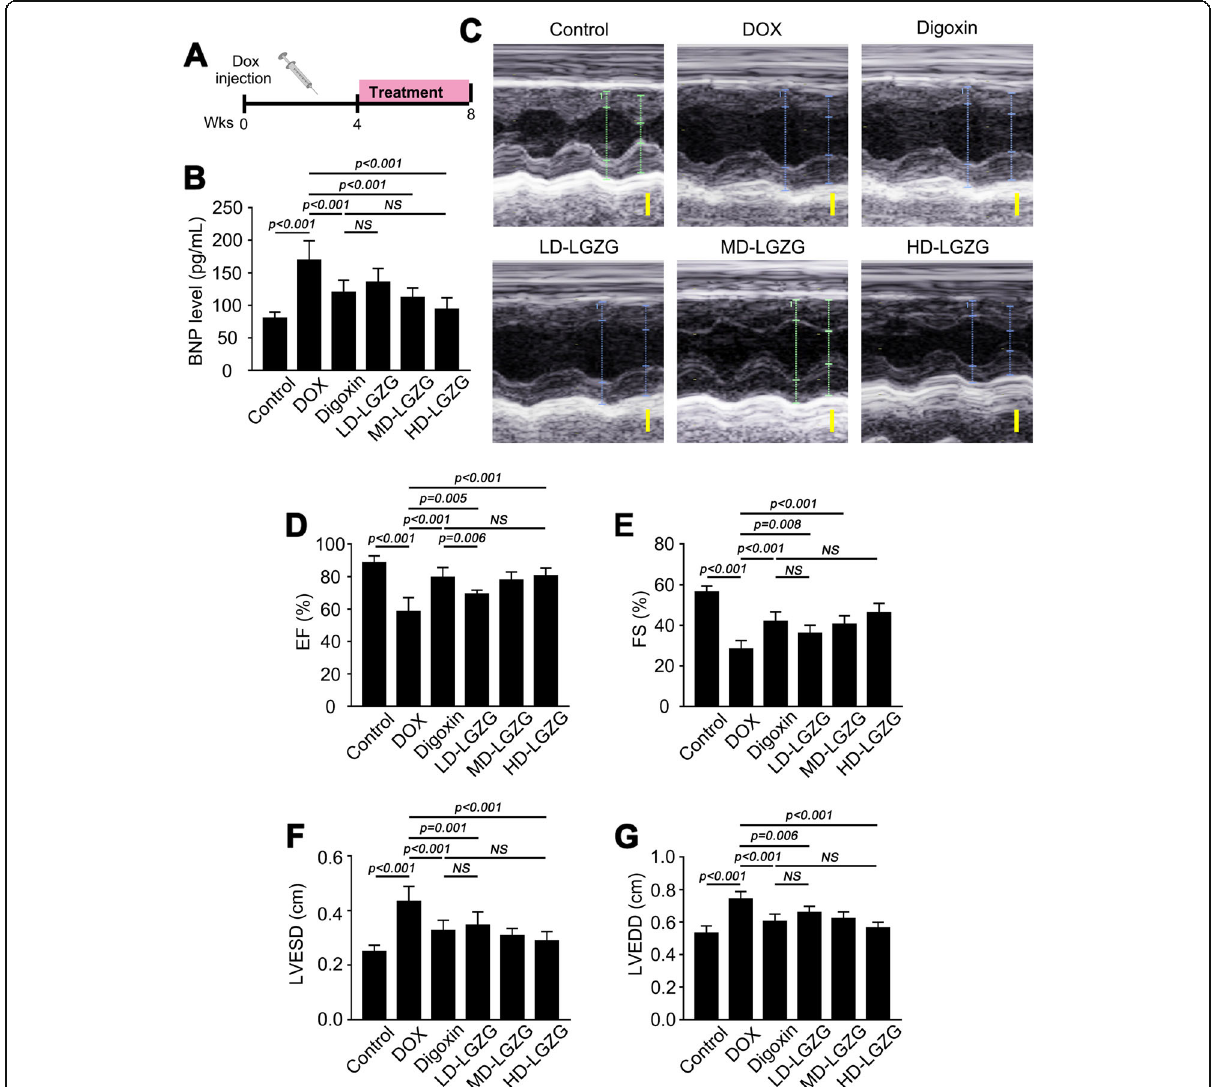
Fig. 1 LGZG improved cardiac function. ( a ) Schematic of HF induction by DOX and the treatment protocol. ( b ) BNP level as determined by ELISA. ( c ) Representative echocardiographic images (scale bar, 0.5 cm). Ejection fraction (EF) and fraction shortening (FS), left ventricular end-systolic diameter (LVESD), and left ventricular end-diastolic diameter (LVEDD) are shown in ( d ), ( e ), ( f ), and ( g ), respectively. The experiment was performed in triplicate. Data are mean ± SEM, n = 8. The observer was blinded to the group assignment. NS, not